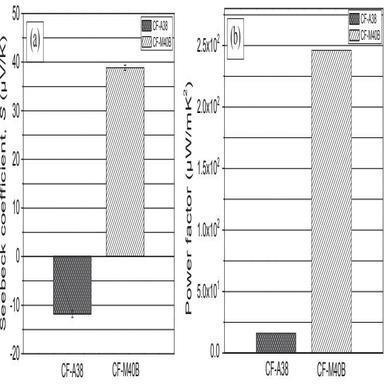
(a) Seebeck coefficient with the corresponding standard deviations, and (b) power factor values of the CF-A38 and CF-M40B tows investigated in this study.